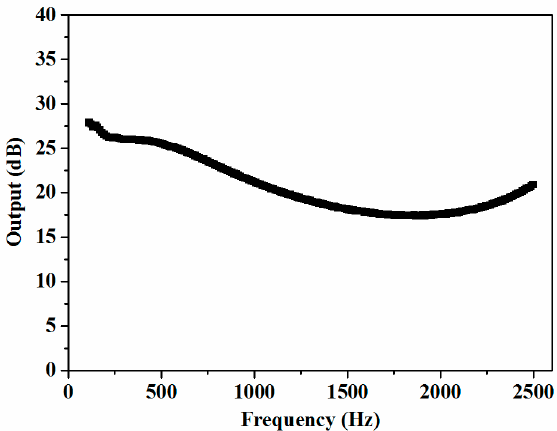
Figure 7. Frequency response of the fabricated sensor compared with that of the calibration 215